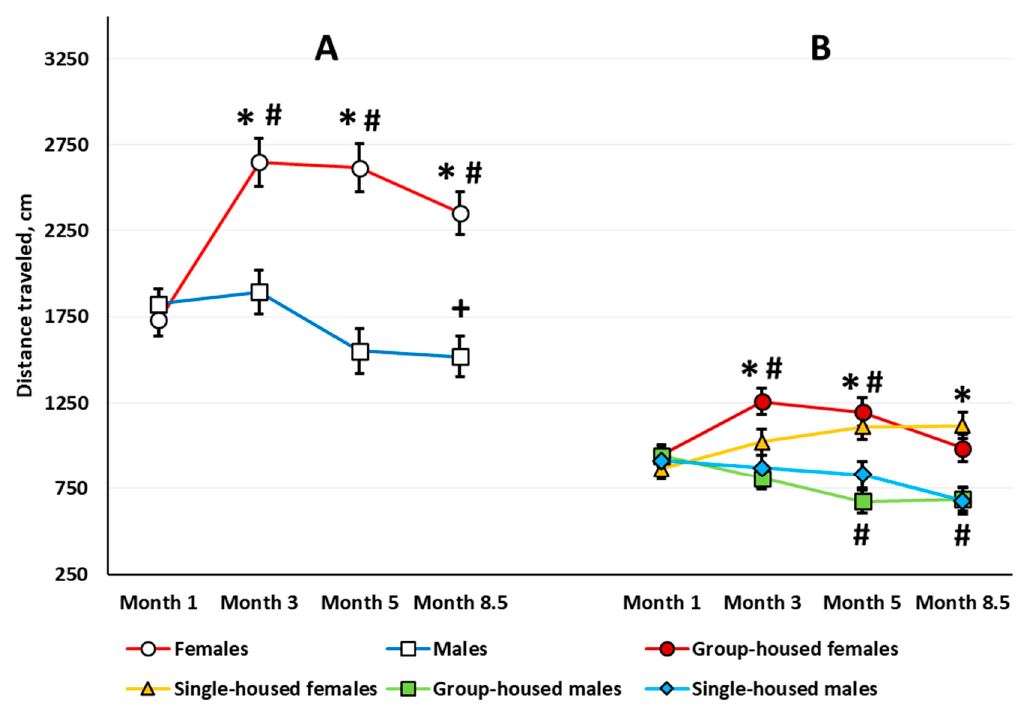
Figure 2. The total distance traveled (cm) for 10 min (sex main effect) ( A ) and the first 3 min (sex × housing interaction) ( B ) in the automated open field test. Here and in other figures, the horizontal axis indicates the age of the rats. The # indicates a statistically significant difference compared with the distance traveled in the 1-month-old rats of the same group, p ≤ 0.039; the * indicates p < 0.001 compared with the distance traveled in the males of the same age and group (single-housed or group-housed); the + indicates p = 0.044 compared with the distance traveled in the 3-month-old males (ANOVA followed by the Newman–Keuls post hoc test). See Supplementary Materials, Table S1, Figure S1.